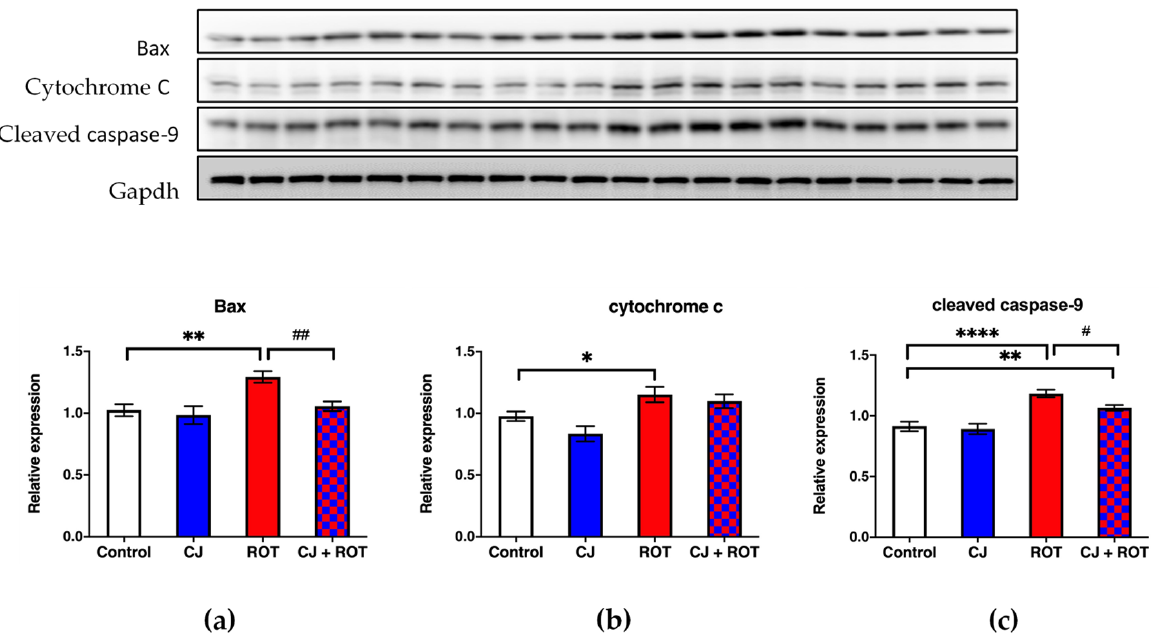
Figure 3. Effect of cranberry juice (CJ) treatment on apoptosis markers. Top panel shows a representative immunoblots. Graphs show relative expression ± SEM of Bax ( a ), cytochrome c ( b ), and caspase-9 ( c ), normalized to GAPDH, in the midbrain of rotenone (ROT) injected rats (n = 8/group). Data were analyzed using one-way ANOVA followed by Fischer’s LSD multiple comparisons test. * p < 0.05 vs. control; ** p < 0.01 vs. control; **** p < 0.0001 vs. control; # p < 0.05 vs. ROT; ## p < 0.01 vs. ROT.